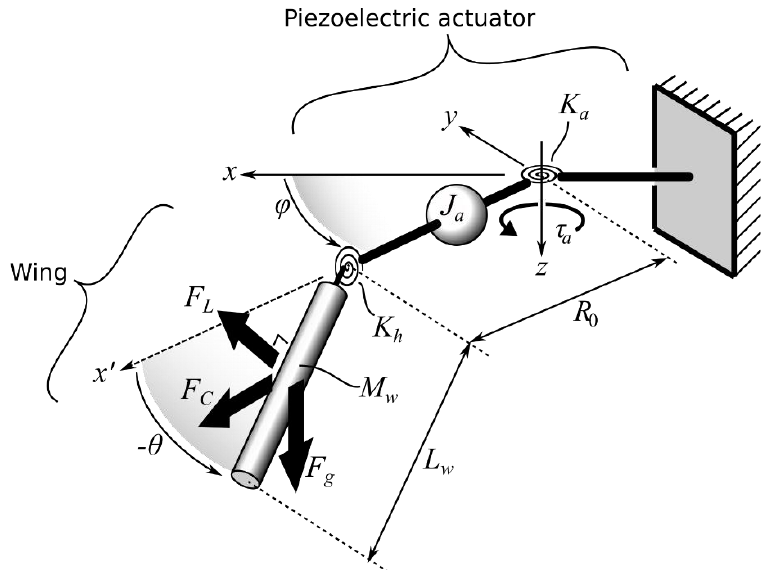
Figure 2. Simplified model of the flapping-wing actuator.